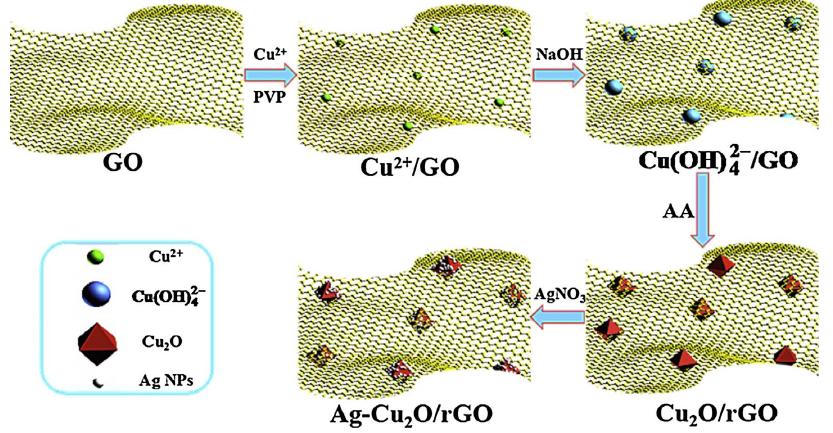
Figure 4. Schematic illustration of synthesis and structure of the Ag-Cu 2 O/rGO composite. Reprinted with permission from [41]. Copyright 2018 Elsevier.